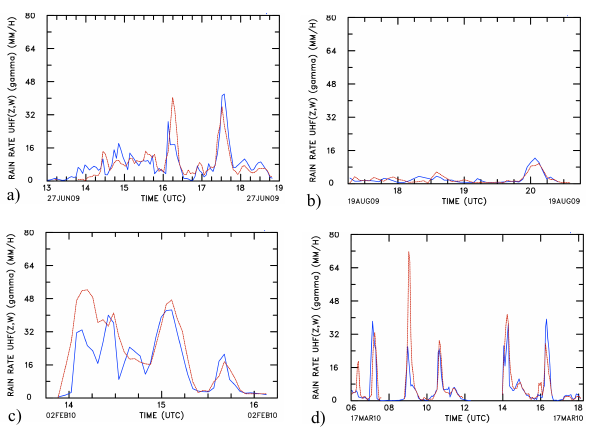
Fig. 9. Time series of rain rate (mmh − 1 ) deduced from UHF profiler data (blue line) between 400m and 500m and for (a) Figure 9: Time series of rain rate deduced from UHF profiler data (blue line) between 400 m 807 27 June 2009, (b) 19 August 2009, (c) 2 February 2010 and (d) and 500 m and for a) 27 Jun. 2009, b) 19 Aug. 2009, c) 02 Feb. 2010 and d) 17 Mar. 2010. 808 17 March 2010. Red lines show corresponding rain-gauge estimates Red lines show corresponding rain-gauge estimates at sea-level. 809 at sea-level. 810